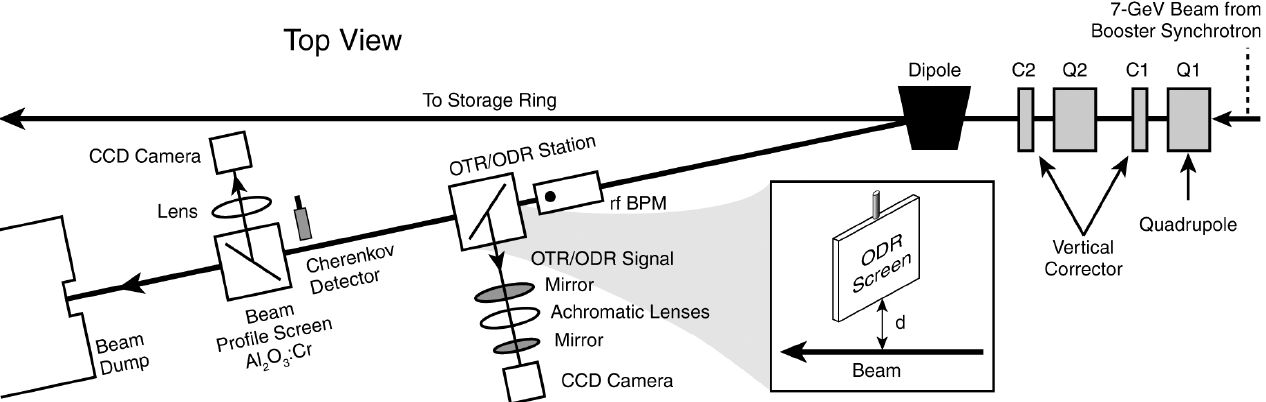
FIG. 1. Schematic of the BTX line at the APS with the rf BPM, OTR/ODR station, Cherenkov detector, beam profiling screen, and beam dump. The upstream dipole whose center is 5.84 m from the station and the vertical correctors are used to direct the beam to the